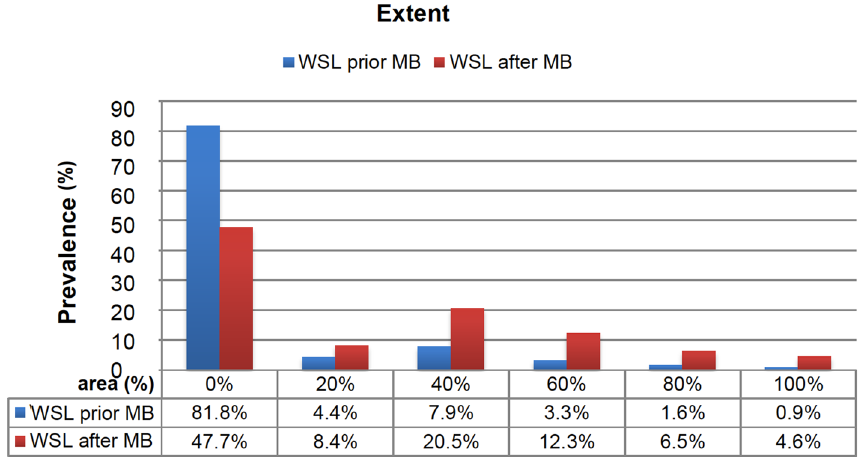
Figure 5. Percentaged distribution of the evaluation index according to the occurrence of WSL. The x-axis of the bar diagram shows the evaluation index (0–100%) and its distribution by percentage upon evaluating WSL, prior to and after MB respectively. The y-axis shows the prevalence in %.